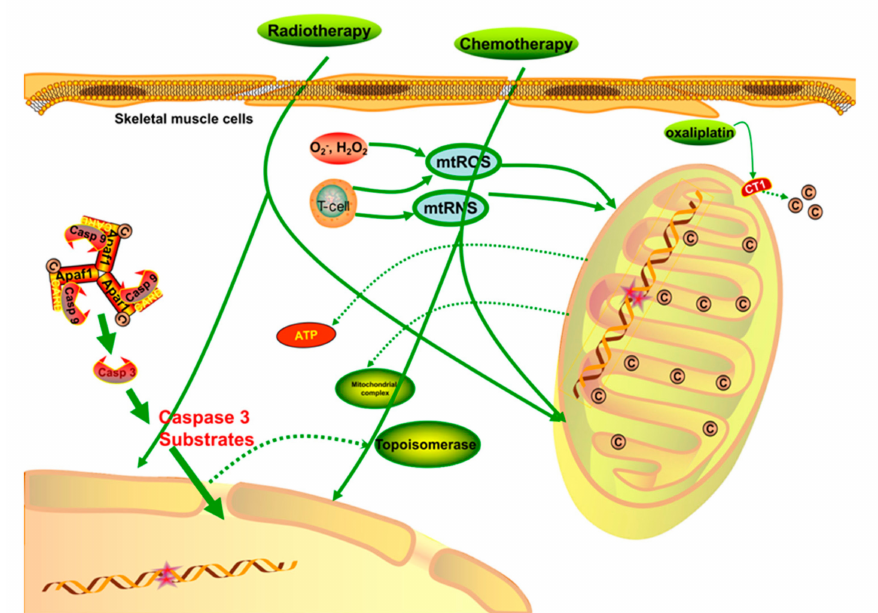
Figure 2. When treated with chemotherapy or radiotherapy, the regular structure and function of mitochondria are damaged through di ff erent signaling pathways. The processes involved in the transcription of nDNA and mtDNA are significantly destroyed, and the levels of mtROS and mtRNS are upregulated when skeletal muscle is nonspecifically targeted by chemotherapies. Meanwhile, the respiratory function of mitochondria is weakened by the impaired mitochondrial membrane. The Cu 2 + capacity is critical for mitochondrial complexes and ATP generation, so when Cu 2 + is competitively inhibited by some chemotherapies, such as oxaliplatin, the outflow of Cu 2 + increases, which is harmful to the mitochondrial energy generation. In general, direct chemo / radio-therapy injuries, hyperoxidative stress, and a low energy supply are likely to cause physical fatigue via apoptosis or other detrimental signaling